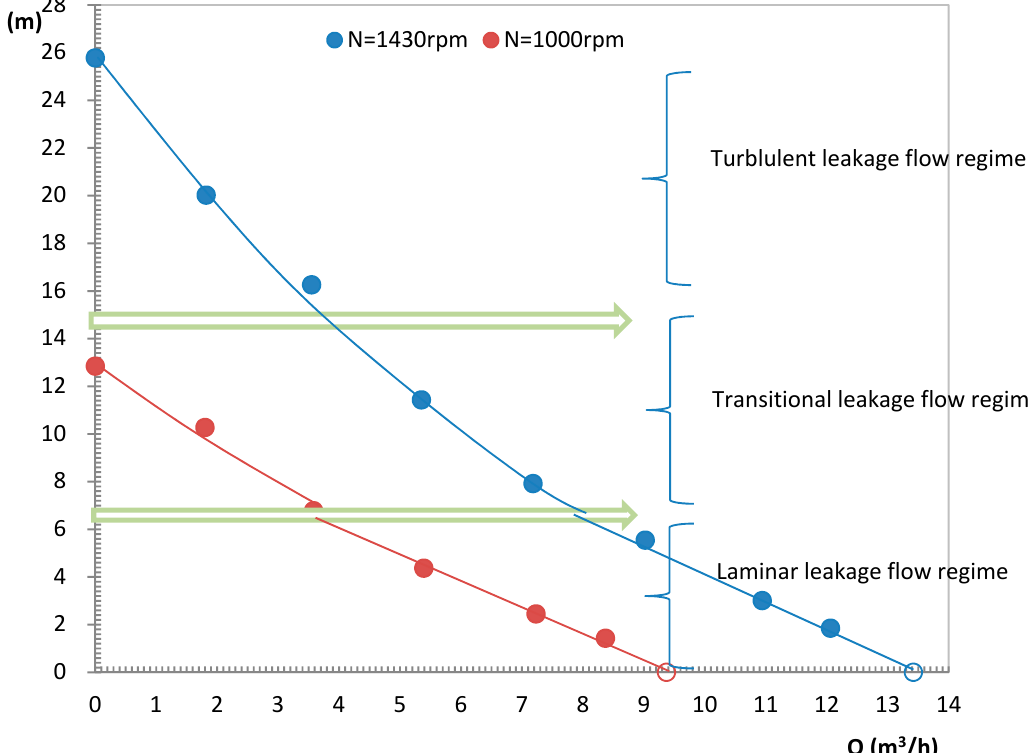
Figure 6. Experimental overall pump performance chart for two rotational speeds.